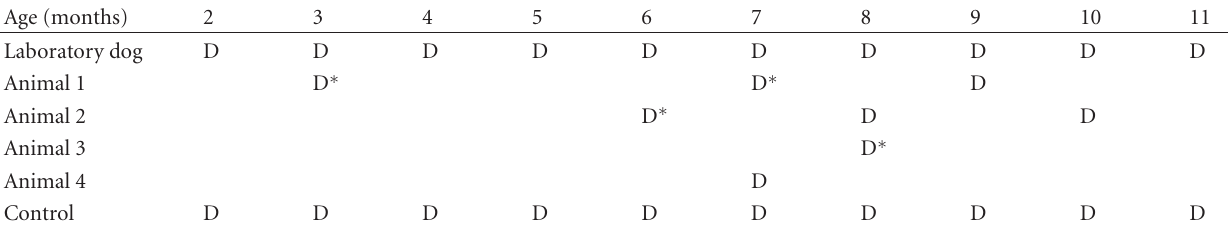
Table 2: Dogs and their age in months at the time of MR